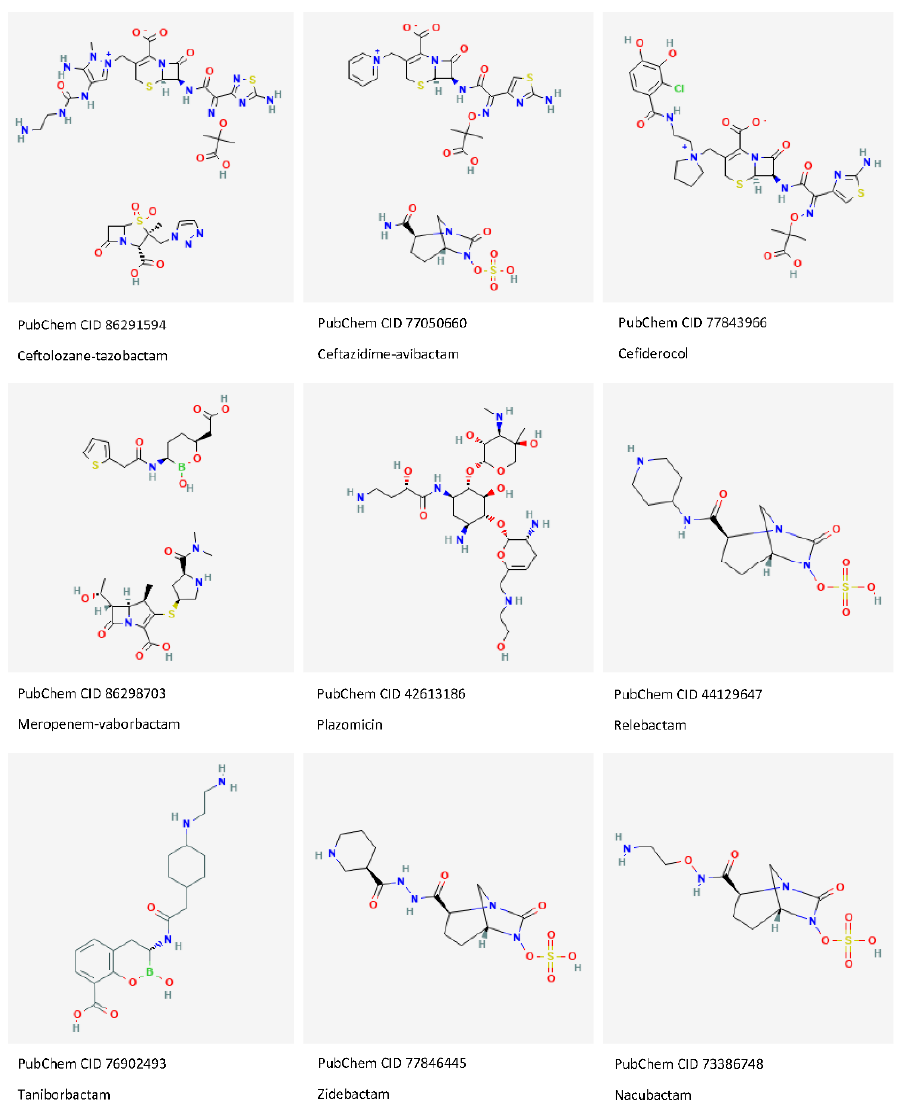
Figure 3. Chemical structures of anti-pseudomonal agents in use and of new β -lactamase inhibitors (Images source: PubChem, https://pubchem.ncbi.nlm.nih.gov/, “2D-Structure”, accessed on 20 April 2022). Table 2. Clinical dosage and renal adjustment for anti-pseudomonal agents.